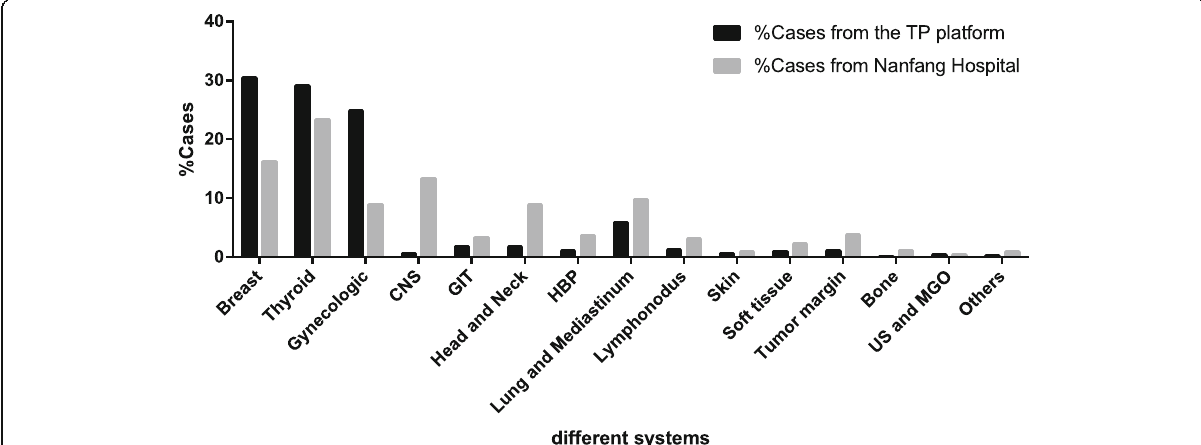
Fig. 2 The distribution of cases among different systems.Abbreviations: CNS, Central nervous system; GIT, Gastrointestinal tract; HBP, Hepatobiliary and Pancreas; US, Urinary system; MGO, Male genital organs